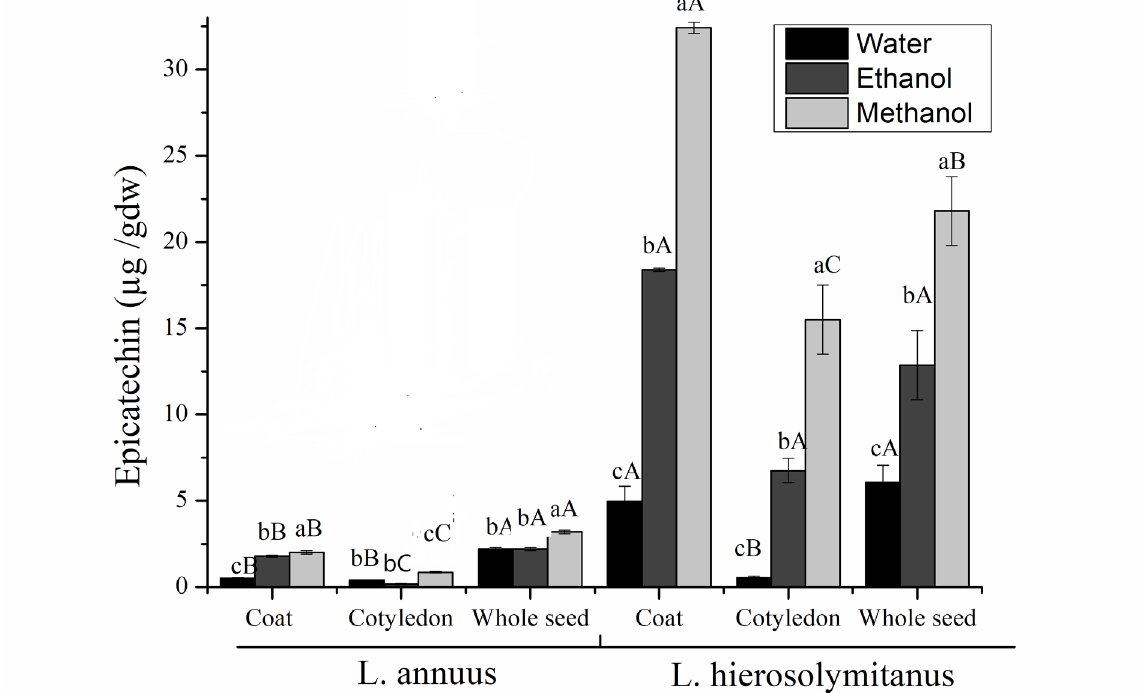
FIGURE 3 - Distribution of epicatechin in Lathyrus seed extracts. Different letter show differences of means among different solvents for each part of each plant species (p < 0.05). Different caps letter shows differences between extracts from different part of the plant in the same solvent for Lathyrus species (p <